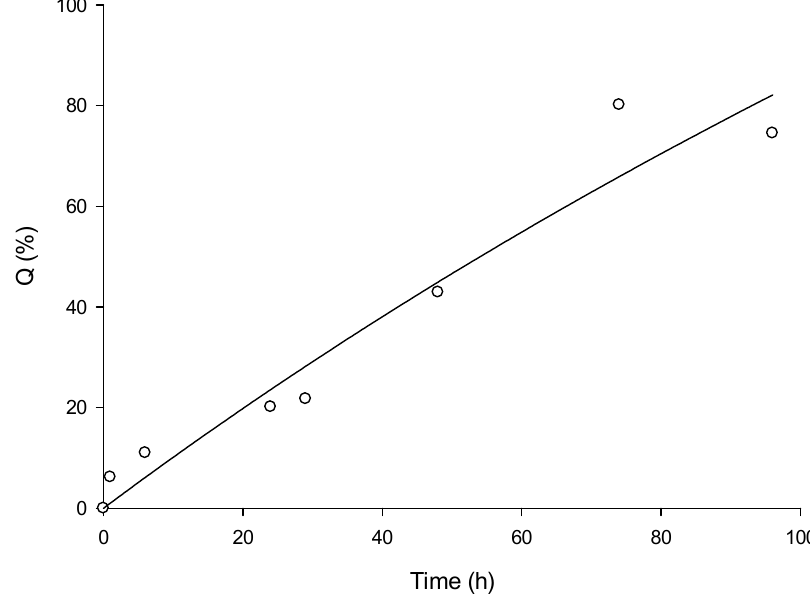
Figure 1. Cumulative release of OEO through cellulose membrane over time from the OEO nanoemulsion, normalized over the initial loading in the donor compartment.